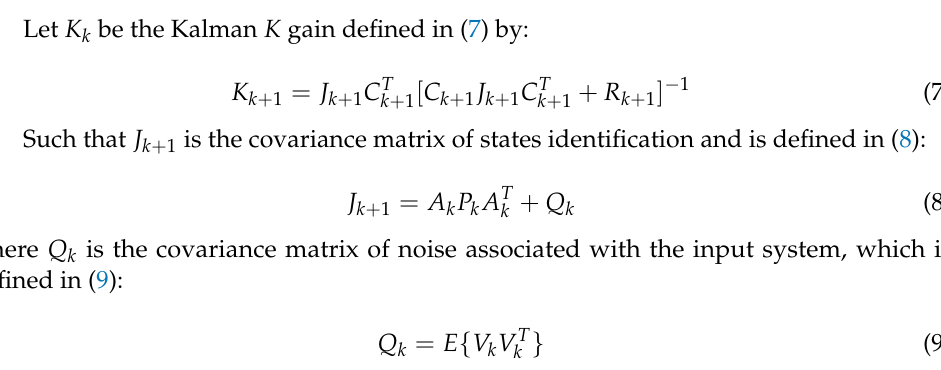
Figure 2. Block diagram of Kalman filtering for communication times